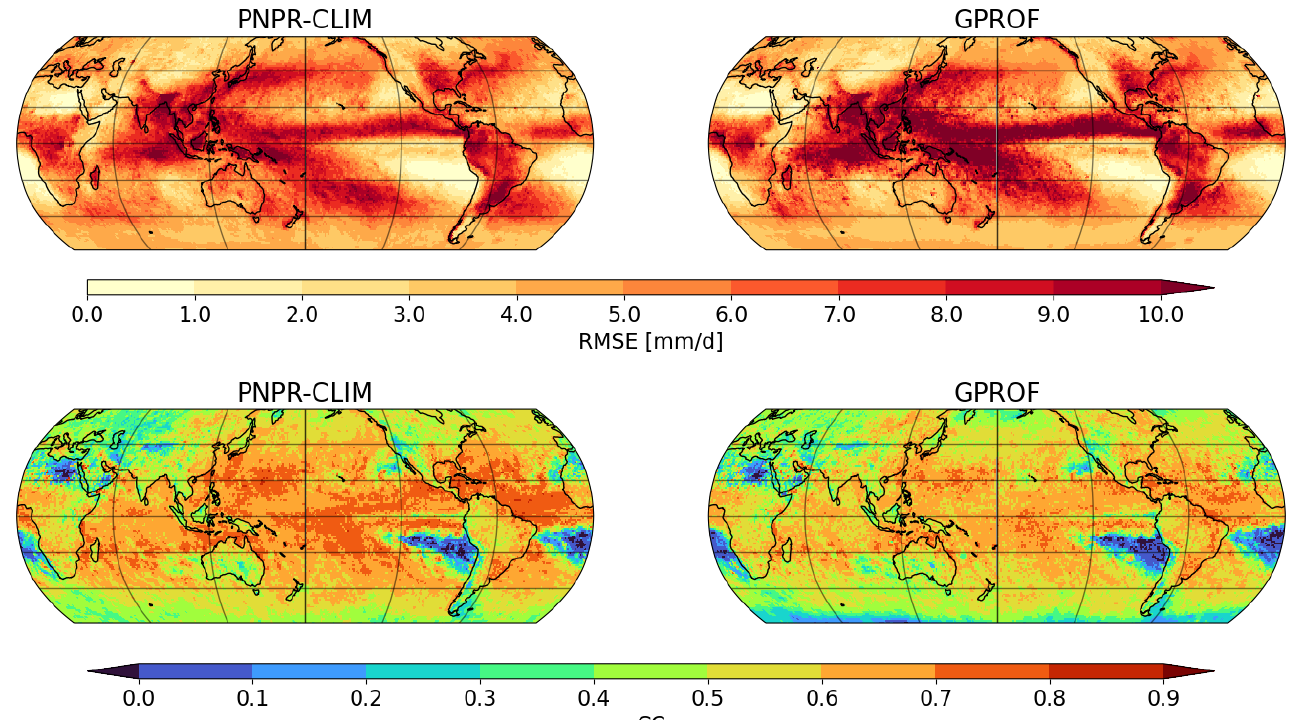
Figure 8. Root mean squared errors ( first row ) and correlation coefficients ( second row ) of PNPR-CLIM ( first column ), GPROF ( second column ) with respect to GPCP over the time period 2015–2017 and between 60 ◦ S and 60 ◦